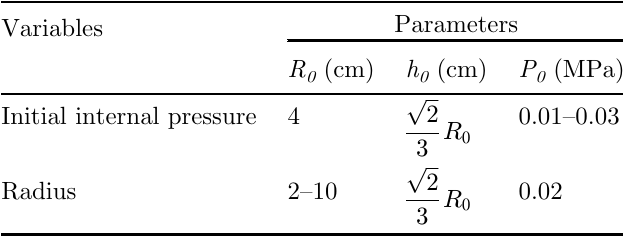
Table 6. Variable parameter